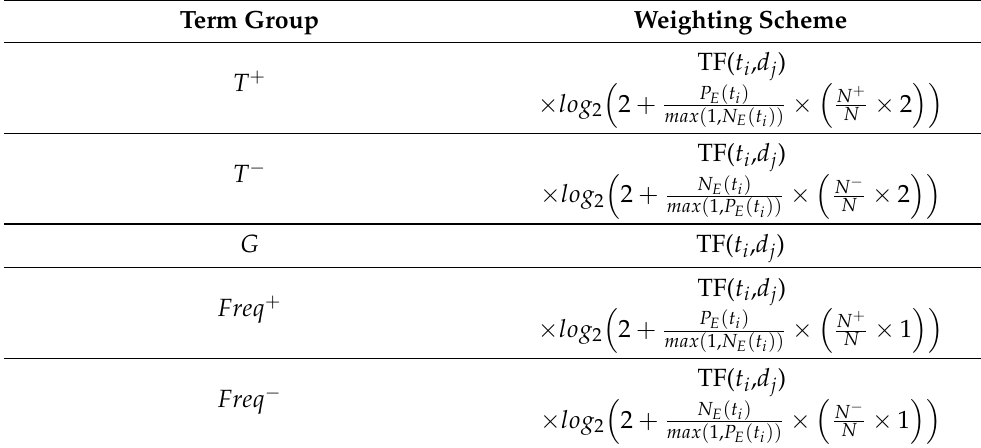
Table 6. Weight revising approach for each